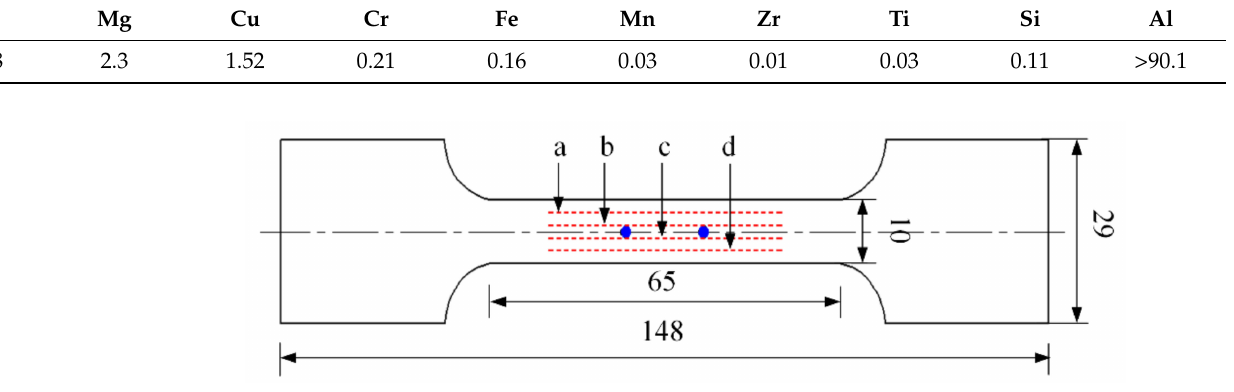
Figure 1. Hot tensile specimen of AA7075 alloy (mm).